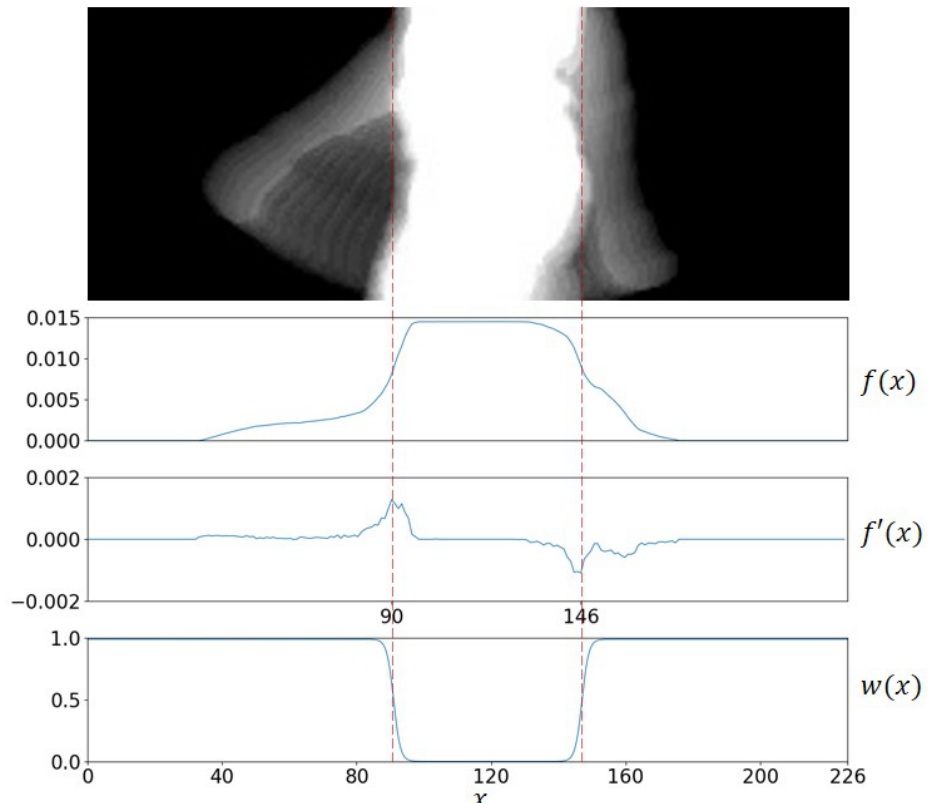
Figure 3. From top to bottom, a ROI including arm motion, the probability density function f ( x ) of foreground data along the x -axis, the first derivative f (cid:48) ( x ) , and the weighting function w ( x ) with k = 1. The inflection points were estimated at x front = 90 and x back =